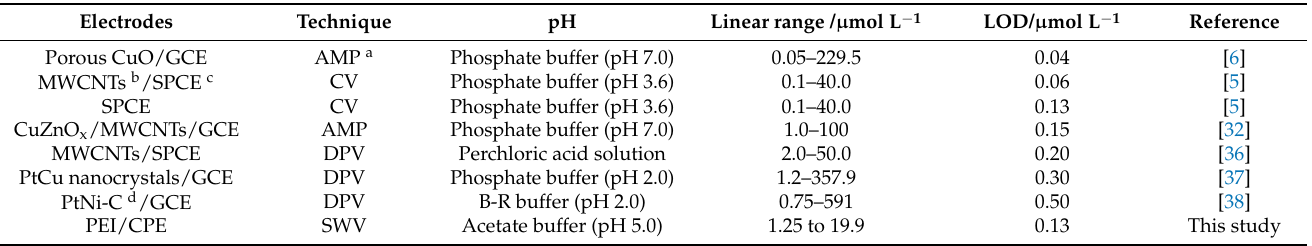
Table 1. Comparison of analytical performance of PEI/CPE with other electrodes in the determination of caffeic